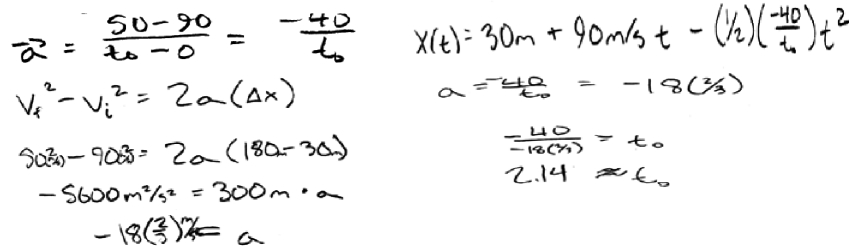
FIG. 8. Use of ‘‘qualitative’’ approach and equations to solve for quantitative solutions from motion graphs.